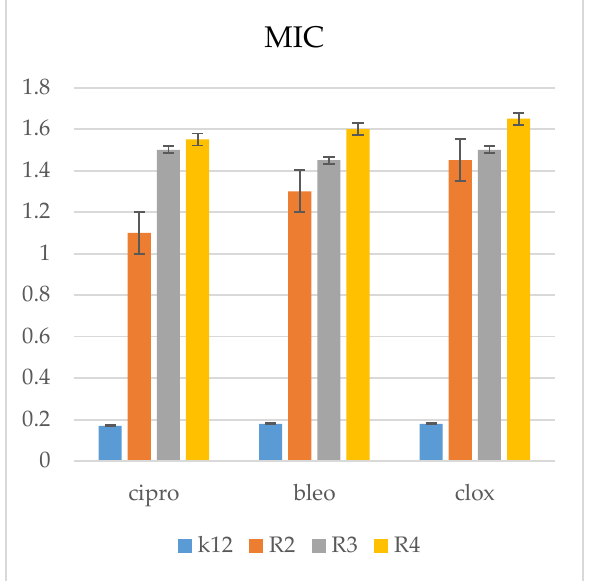
Figure 8. Examples of MIC with model bacterial strains K12, R2, R3, and R4 for studying antibiotics ciprofloxacin (cipro), bleomycin (bleo), and cloxacillin (clox). The x -axis features antibiotics used sequentially. The y -axis features the MIC value in µg/mL − 1 .